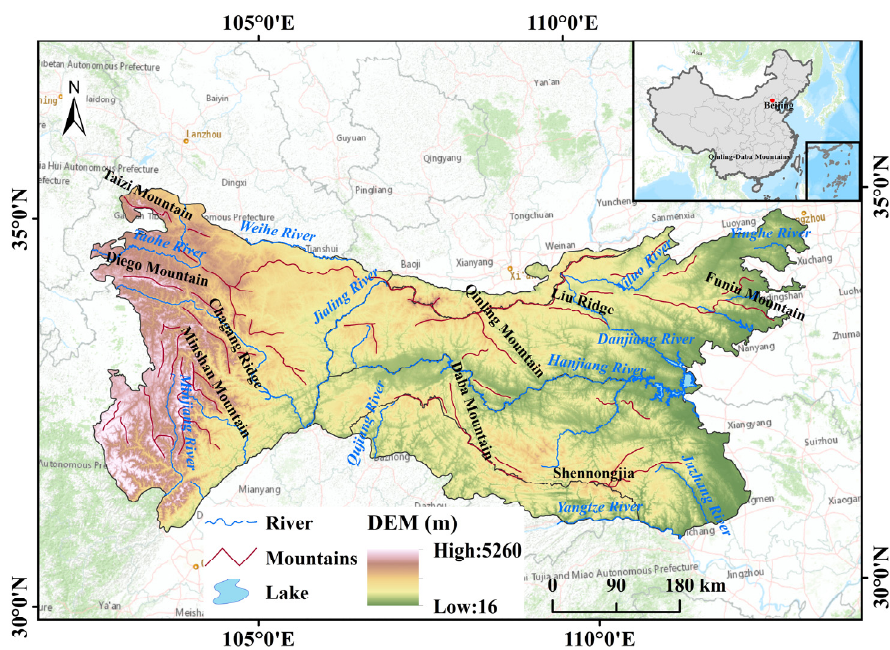
Figure 1. Location of the Qinling-Daba Mountains.